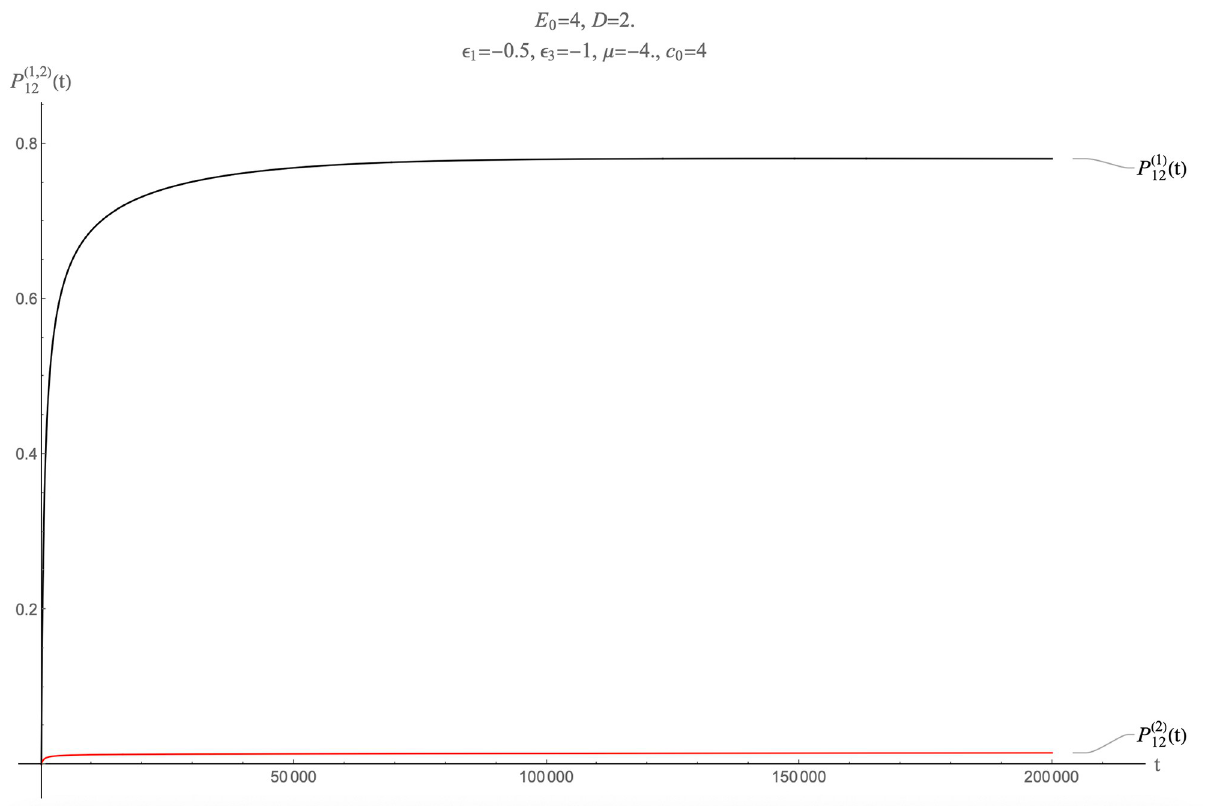
Fig 16. Packaging competition for c 0 = 4.0 and D = 2. The other parameters are the same as for Fig